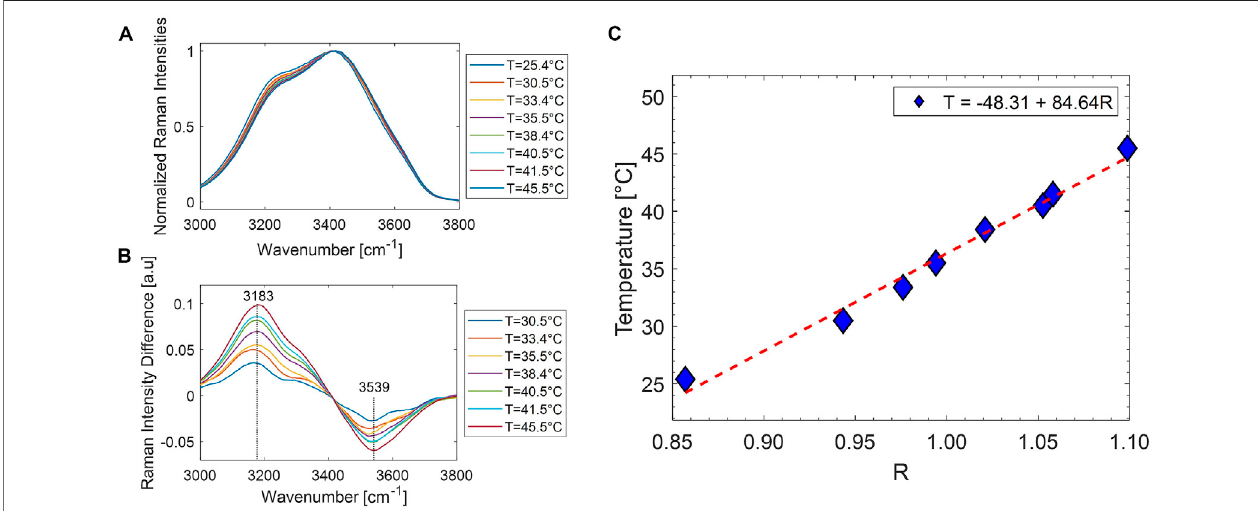
FIGURE 4 | (A) Raman water bands in the 3,000- to 3,800-cm − 1 spectral range, normalized to the prominent feature at 3,400 cm − 1 , obtained at different temperatures. When temperature increases, the low wavenumber side decreases accordingly. (B) Difference in the spectra reported in part A with respect to the correspondingoneat25.4 ° C. (C) Trendoftheratio Rvs. T,togetherwiththelinecorrespondingtoalinear fi ttingofthedata.Thecalibrationlineequationisalsoindicated.